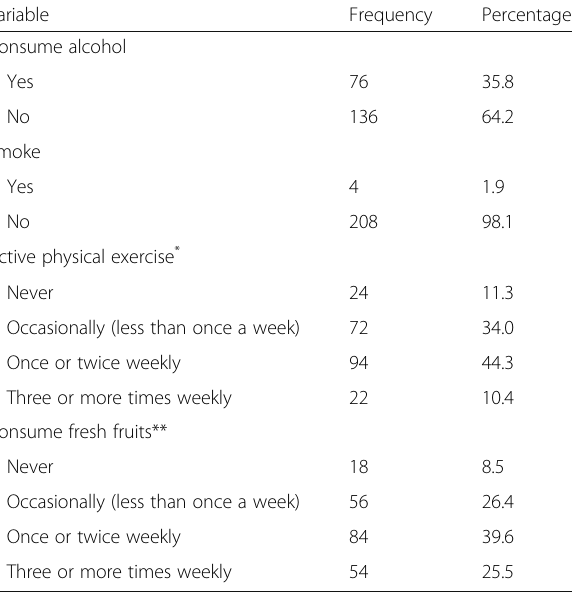
Table 2 Behavioral characteristics of hypertensive